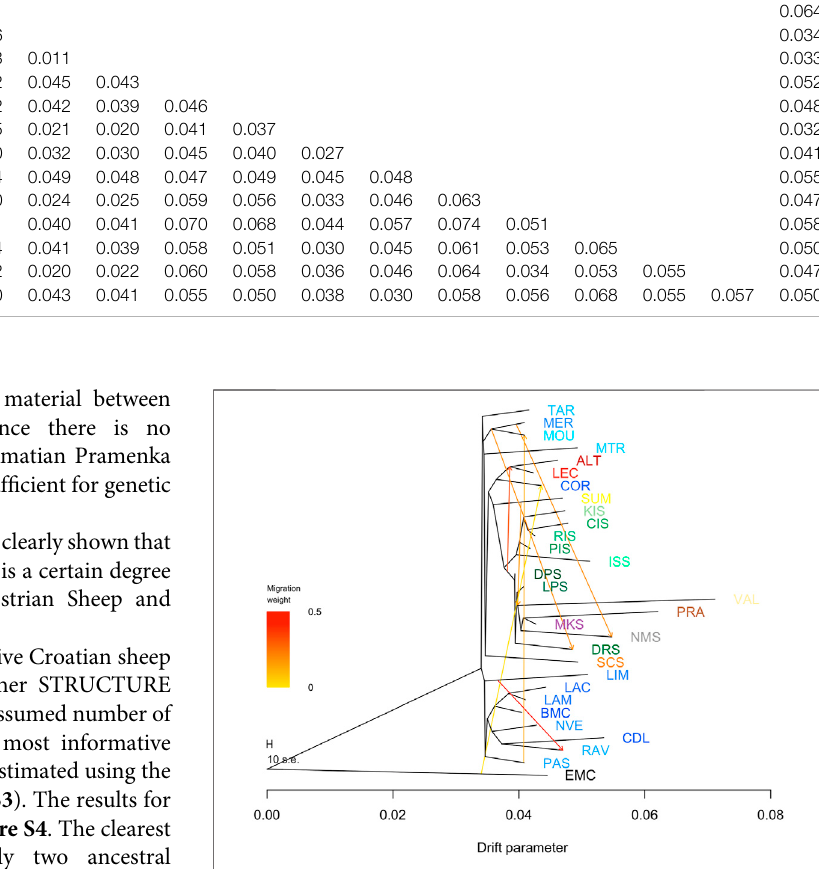
FIGURE 3 | Inferred maximum likelihood population graph considering 12 migration events. Migration arrows are coloured according to their weight. The length of the horizontal branches is proportional to the amount of genetic drift that occurred on each branch. The tree was derived using TreeMix v.1.12. The European mou fl on was set as the outgroup. Each country is presented with different colour: Croatia — green; France — blue; Spain — orange; Italy — red; North-Macedonia — grey; Ukraine — purple; Czech Republic — yellow; Serbia — brown. Within a country, each breed is represented with a different main colour and three-letter coding: DRS, Dubrovnik Sheep; LPS, Lika Pramenka; DPS, Dalmatian Pramenka; PIS, Pag Island Sheep; RIS, Rab Island Sheep; CIS, Cres Island Sheep; KIS, Krk Island Sheep; ISS, Istrian Sheep; PRA, Serbian Pramenka; VAL, Valachian; MKS, Mount Carpatian Sheep; NMS, North Macedonian Pramenka; SUM, Sumavaska; ALT, Altamunrana; LEC, Leccese; SCS, Churra; COR, Corse; MER, Merino; NVE, Noire du Velay; CDL, Causse du Lot; RAV, Rava; BMC, Blanche du Massif Central; LAM, Meat Lacaune; LAC, Milk Lacaune; LIM, Limousine; TAR, Tarasconnaise; MTR, Manech Tete Rouge; PAS, Preaples du Sud; MOU,